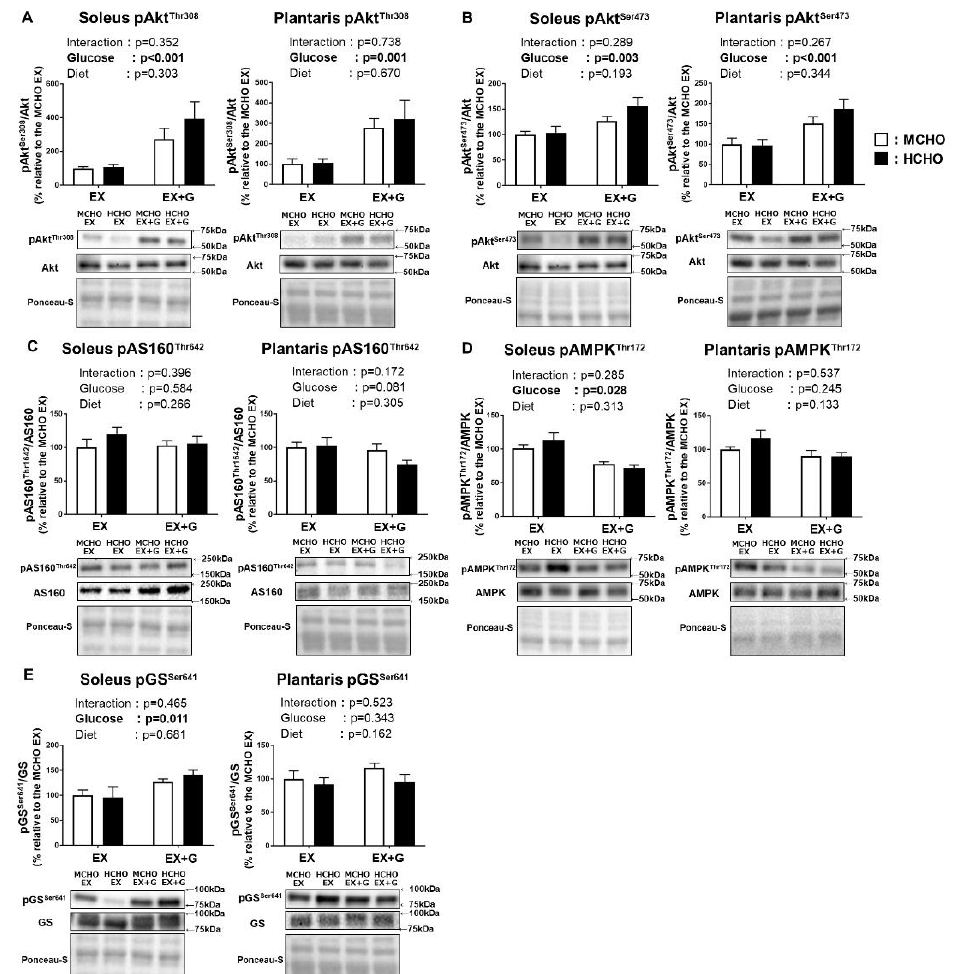
Figure 6. Phosphorylation levels of Akt Thr 308 ( A ), Akt Ser 473 ( B ), Akt substrate 160 kDa (AS160) Thr 642 ( C ), AMP-activated protein kinase (AMPK) Thr 172 ( D ), and glycogen synthase (GS) Ser 641 ( E ) in mice fed the HCHO (black) or MCHO (white) diet for 10 days (n = 6–8). Tissues were harvested as described in the Figure 2 legend. Values are mean ± SE. All data are shown as relative values against the MCHO EX group.